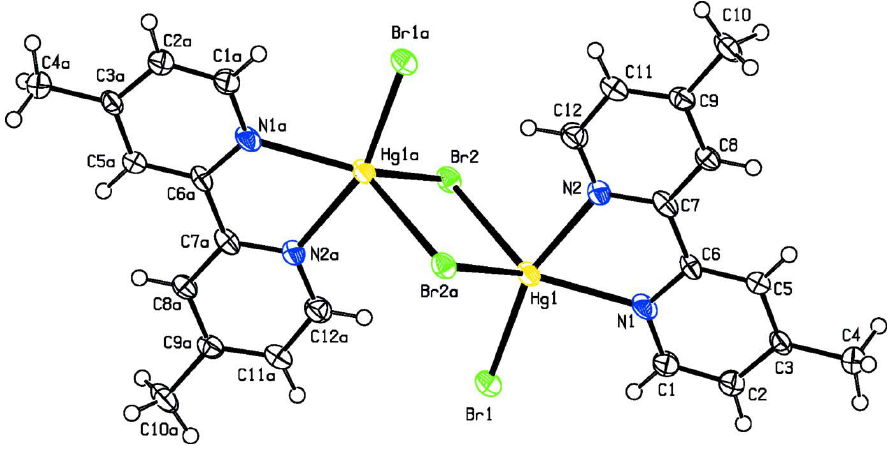
Figure 1 The molecular structure of the title molecule, with the atom-numbering scheme. Displacement ellipsoids are drawn at the 50% probability